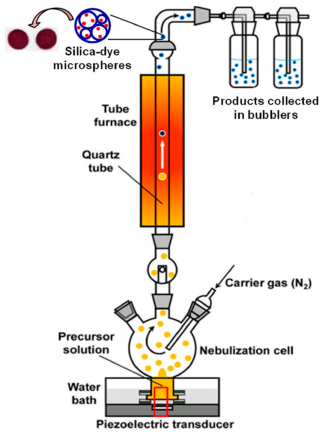
Figure 1. Ultrasonic spray synthesis of the porous silica-dye composite